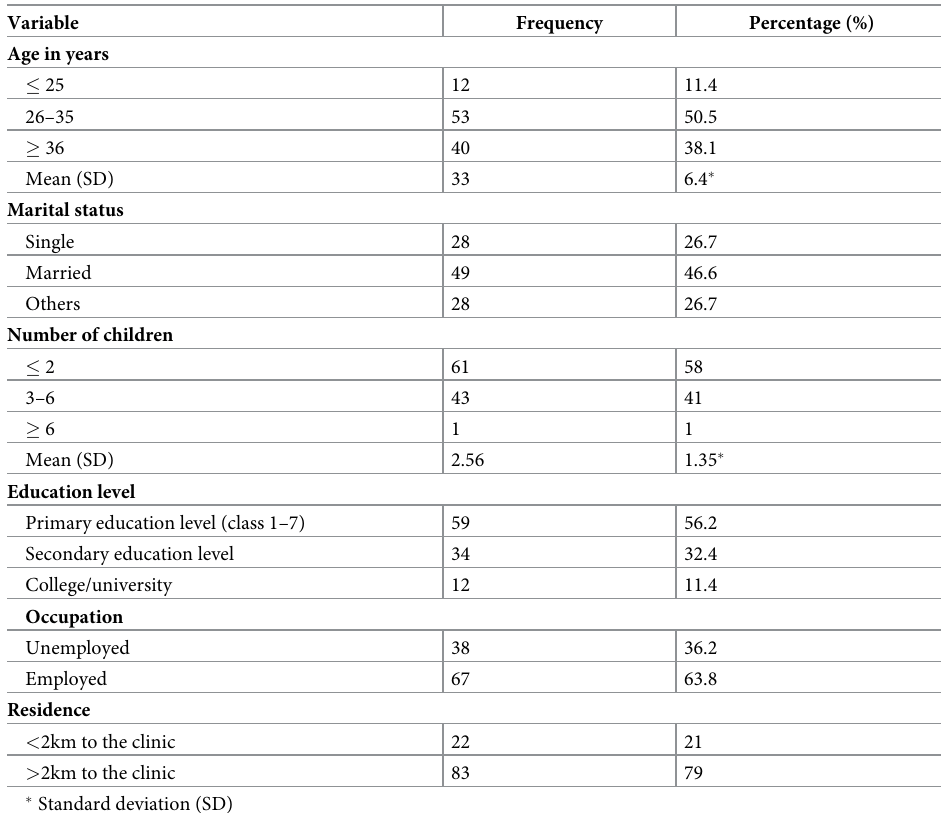
Table 1. Demographic characteristics of participants (n = 105).